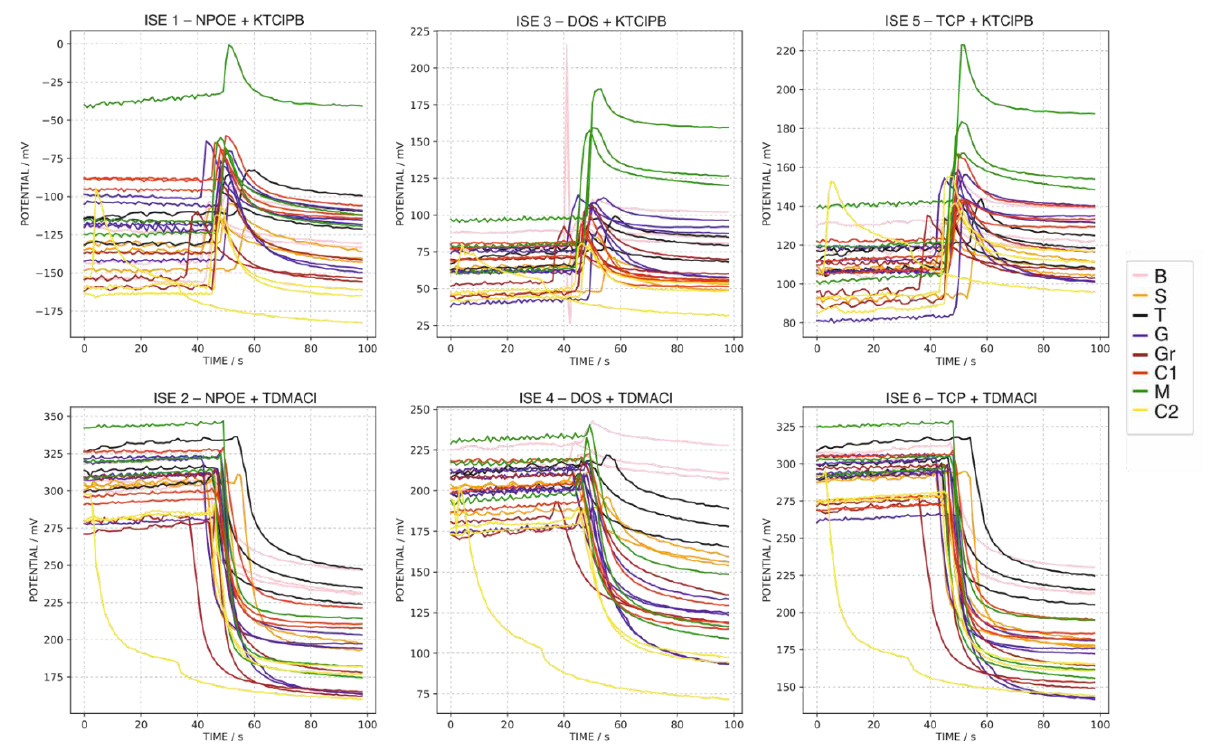
Figure 2. Triplicate dynamic potential responses of ISEs 1 – 6 observed for all the water samples, except MT, applying the first measurement protocol (MilliQ water background).